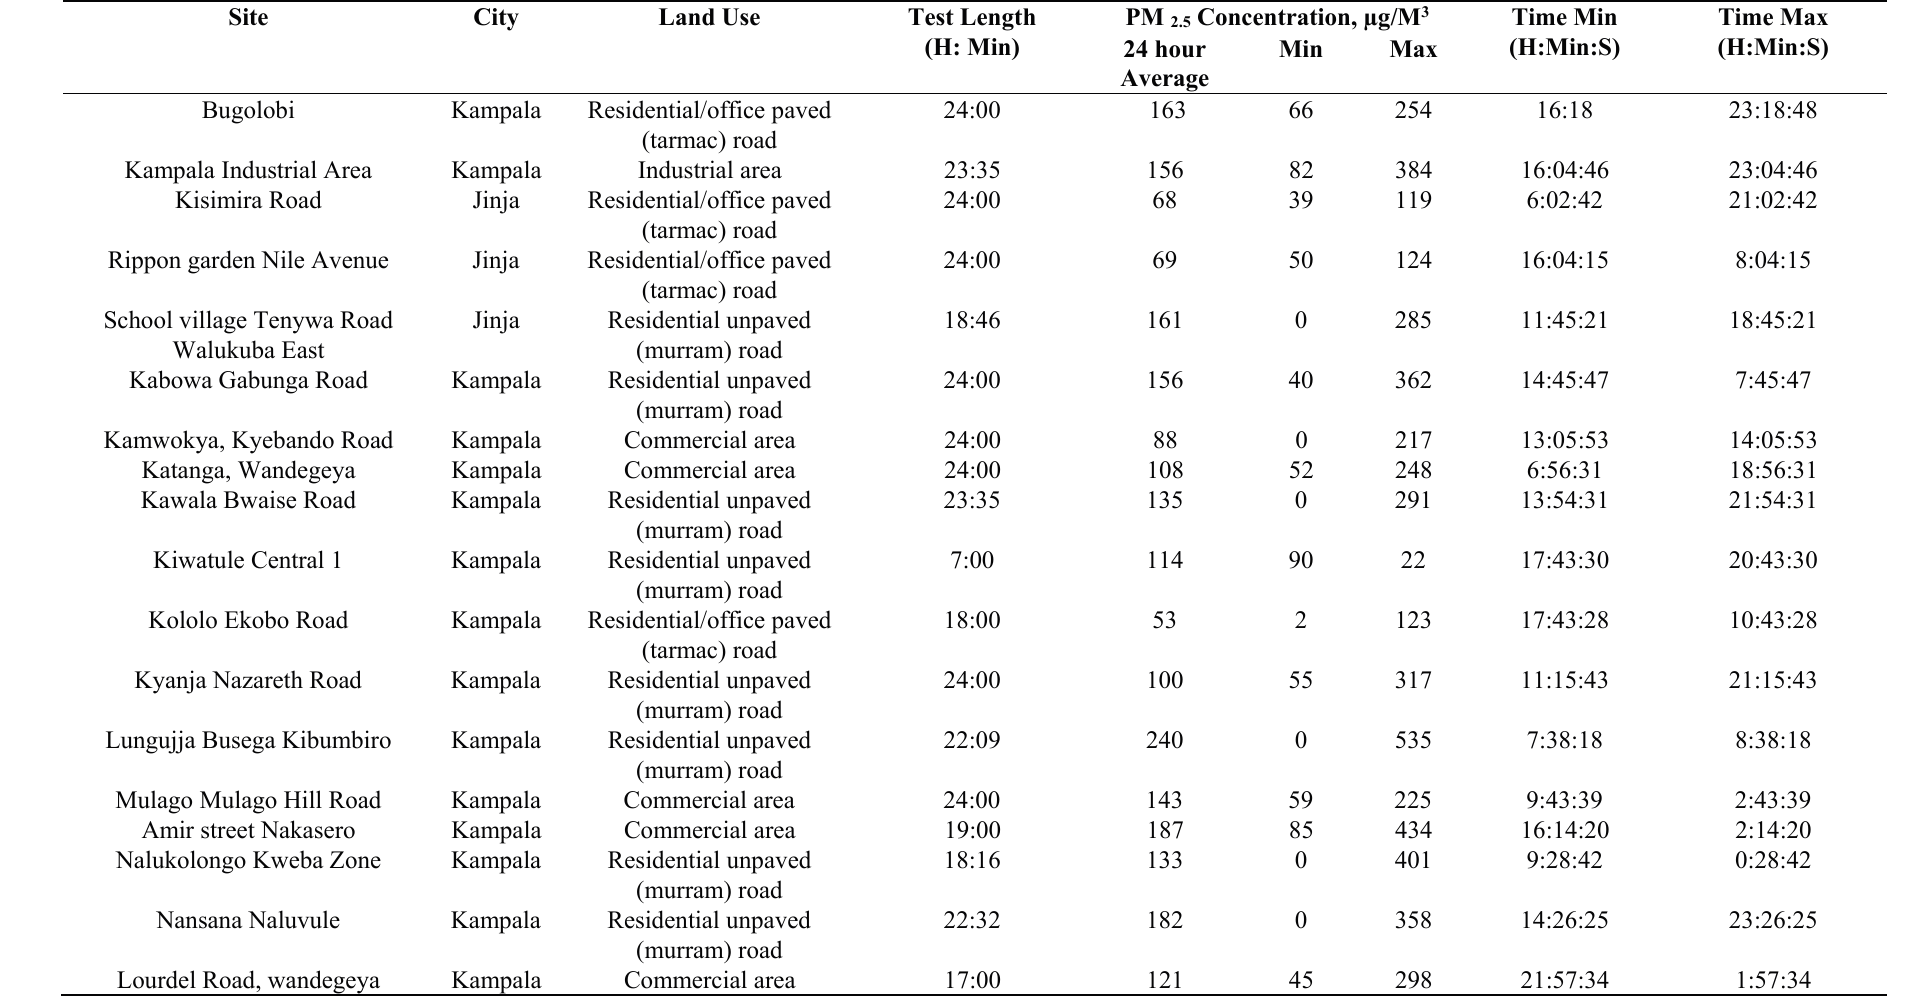
Table S1. PM 2.5 concentrations at different sites in Kampala and